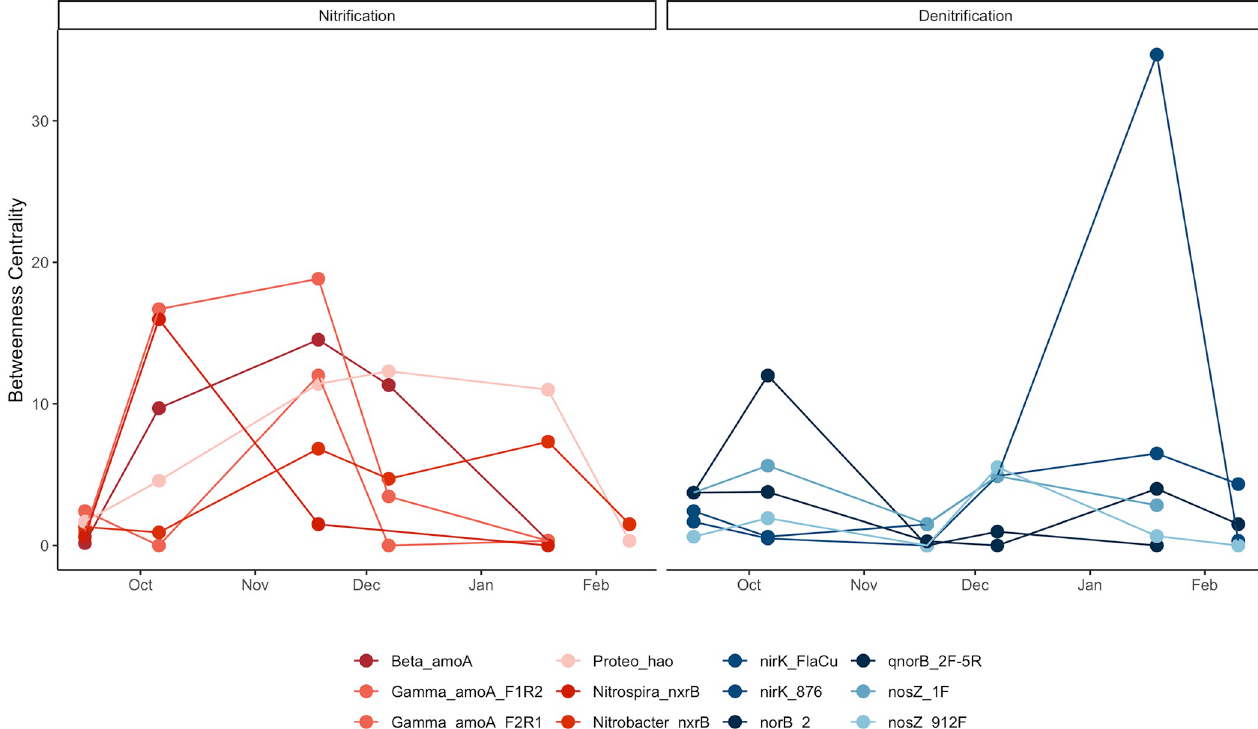
Fig 5. Betweenness centrality of putative keystone genes varies by time in tropical rainfed pasture soils. We selected a subset of nitrification and denitrification gene targets, shown here, and identified them as keystones based on node degree, betweenness centrality, and closeness centrality.